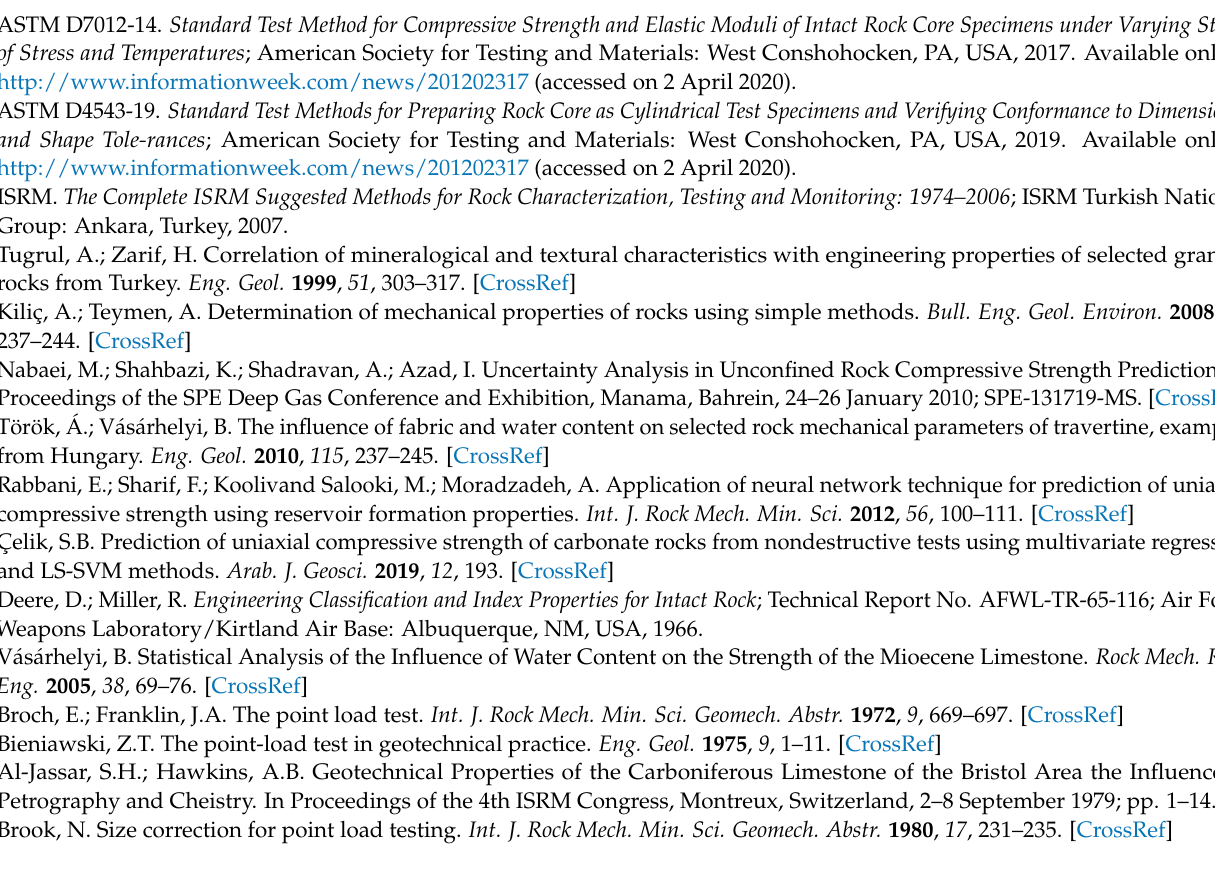
Figure 9: σ c (31) ), the model was descending, having a mixed (ascending-and-descending) model with a d i around 31 mm. For the descending model, which included the estimates of σ c (from I s , I s (50) , and R N ) that favored this trend, coefficients k 1 and k 2 of +0.858 and +1.160, respectively, were obtained whose difference of 0.30 generates an error of 25.9% with respect to k 2 , the only experimental